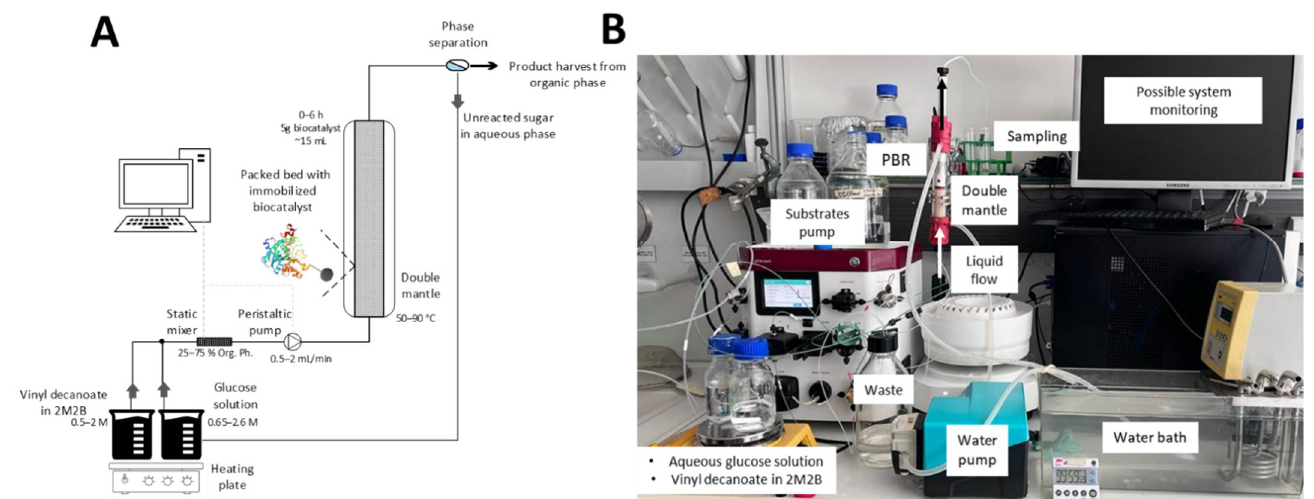
Figure 6. Process flow diagram of the set-up applied in this study using a Packed Bed Reactor (PBR). ( A ) Process flow diagram. ( B ) Picture of the laboratory set-up. Samples were centrifuged for 3 min at 4000× g using a Multifuge X3 FR centrifuge